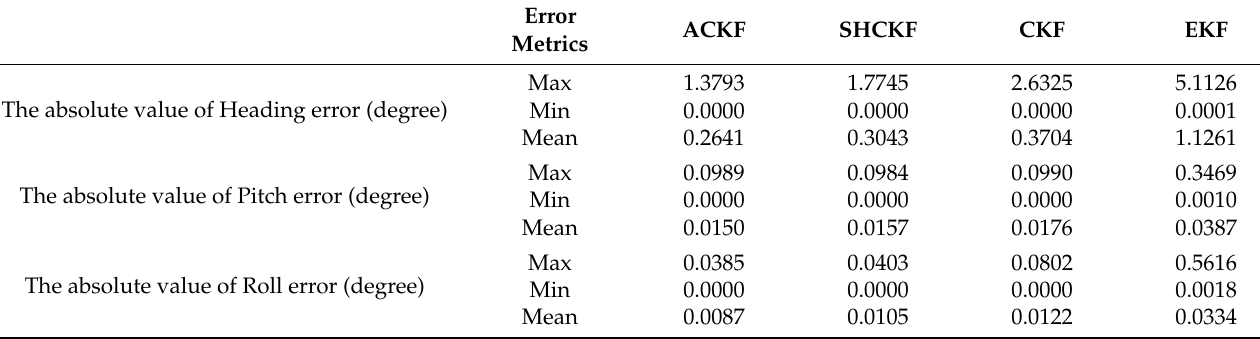
Figure 5. The results of the static test: ( a ) heading angle; ( b ) absolute value of the heading error; ( c ) pitch angle; ( d ) absolute value of pitch error; ( e ) roll angle; and ( f ) absolute value of the roll error. Table 1. Statistical results of the absolute value of heading, pitch, and roll error in the static